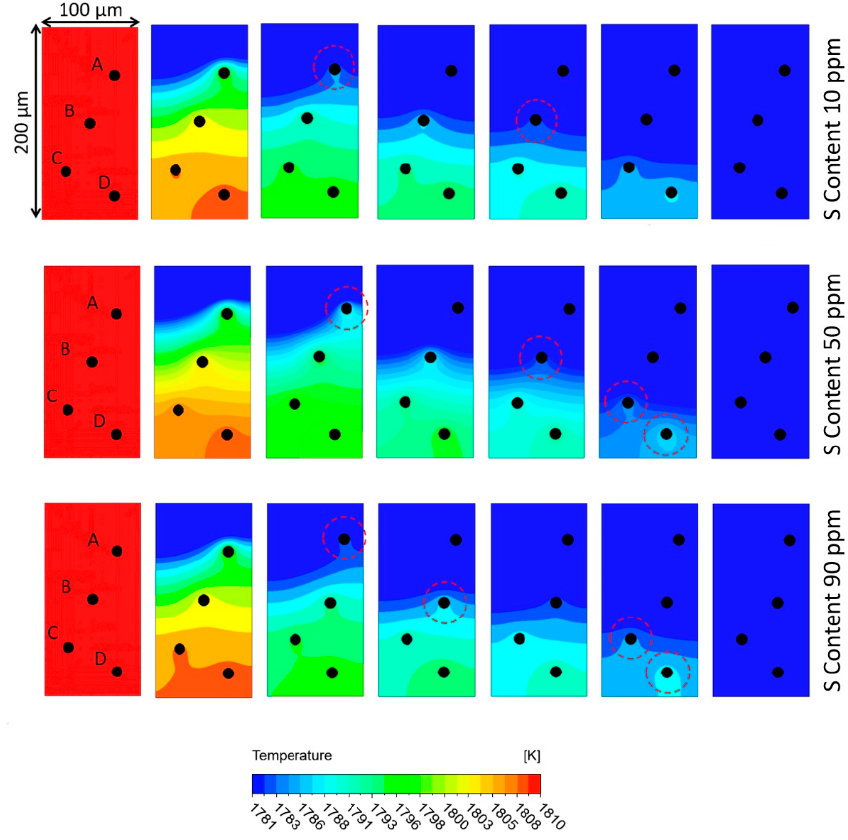
Figure 11. Pushing and engulfment of alumina inclusion particles during solidification of the weld pool.